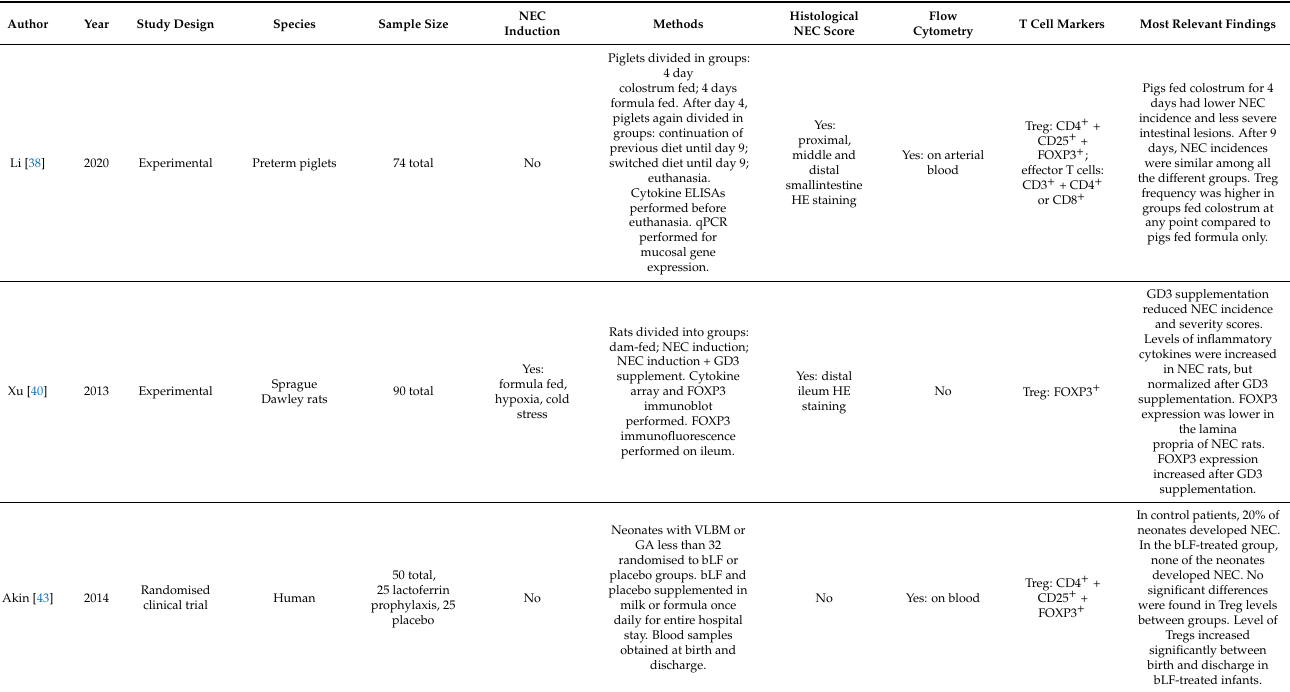
Table 3. Characteristics and main findings of included breastmilk related